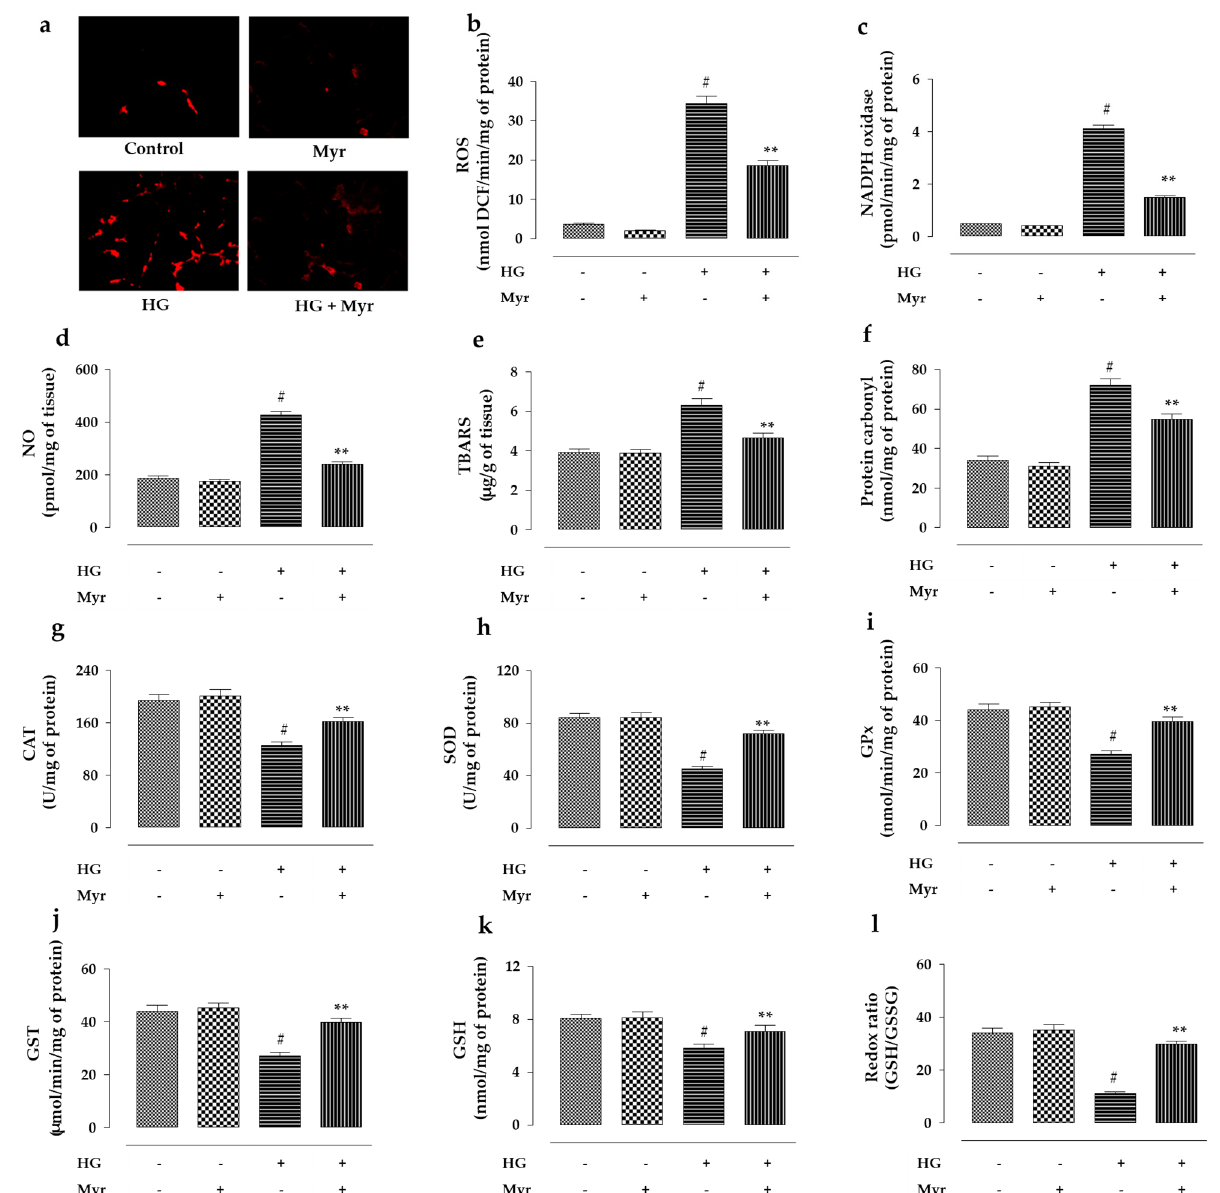
Figure 4. The effects of Myr on HG-induced redox imbalance on NRK cells. ( a ) The level of intracellular ROS was observed in cells by DCF fluorescence. ( b ) The graph showing the quantity of intracellular ROS. ( c – l ) The graphs showing the effects on NADPH oxidase ( c ), NO ( d ), TBARS ( e ), protein carbonyl ( f ), CAT ( g ), SOD ( h ), GPx ( i ), GST ( j ), GSH ( k ), and redox ratio ( l ). Myr was effective in reducing HG-induced increase in intracellular ROS, NADPH oxidase, NO, TBARS, and protein carbonyl levels, while it increased CAT, SOD, GPx, GST, GSH, and redox ration in HG-exposed NRK cells. Data are represented as the mean ± SD, n (number of plates) = 3. # Values significantly ( p < 0.01) differed from the control (HG − group. ** Values significantly ( p < 0.01) differed from the HG-treated (HG+) group. SOD unit, “U”, is defined as inhibition (µ-moles) of nitro blue tetrazolium (NBT)-reduction/min. CAT unit, “U”, is defined as H 2 O 2 consumption/min.